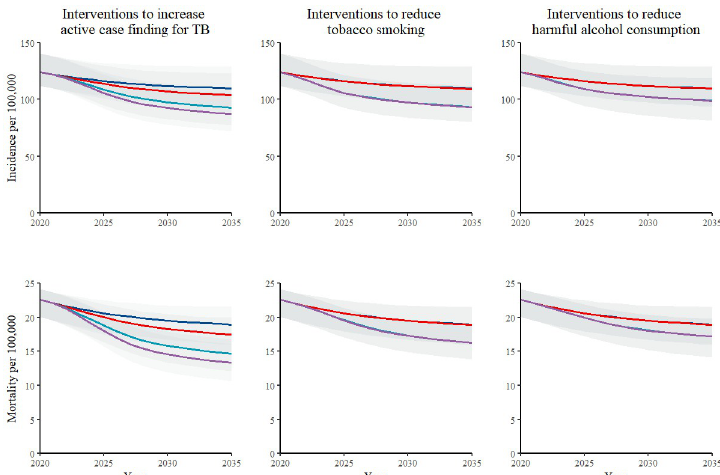
Fig 2. Projections for total population incidence (top) and mortality (bottom) for interventions to increase active case finding for TB (left), to reduce tobacco smoking (middle), and to reduce harmful alcohol consumption (right). Each plot shows median model estimates (lines) and model uncertainty (shaded area) for the baseline calibration (dark blue) and intervention scenario targeting men (light blue), targeting women (red), and targeting both men and women